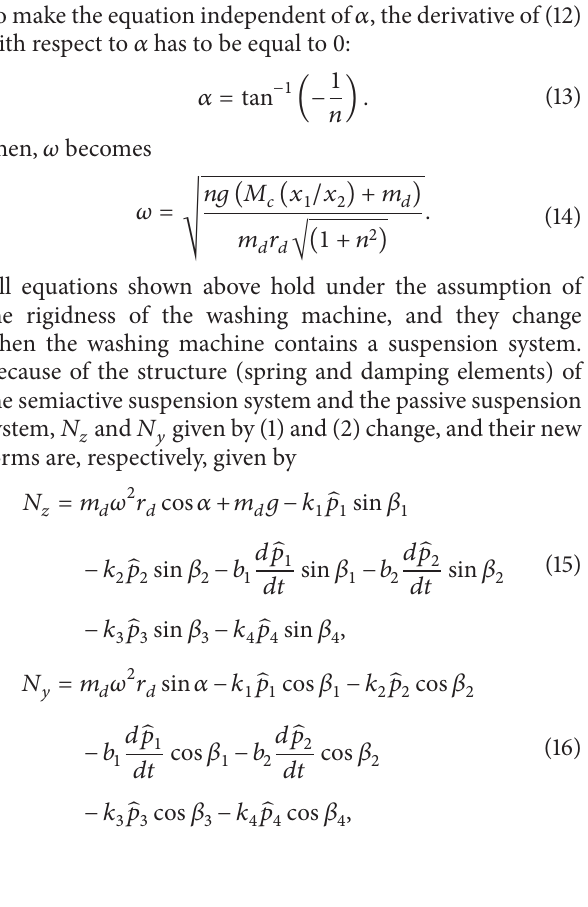
The second assumption pertains to the rigidness of the washing machine, with the forces produced by rotating clothes ( 𝑁 𝑦 , 𝑁 𝑧 ) and friction forces on feet ( 𝐹 𝐴 , 𝐹 𝐵 , 𝐹 𝐶 , and 𝐹 𝐷 ) shown in Figure 1. Points 𝐴 , 𝐵 , 𝐶 , and 𝐷 , respectively, indicate the front left, front right, back left, and back right feet of the washing